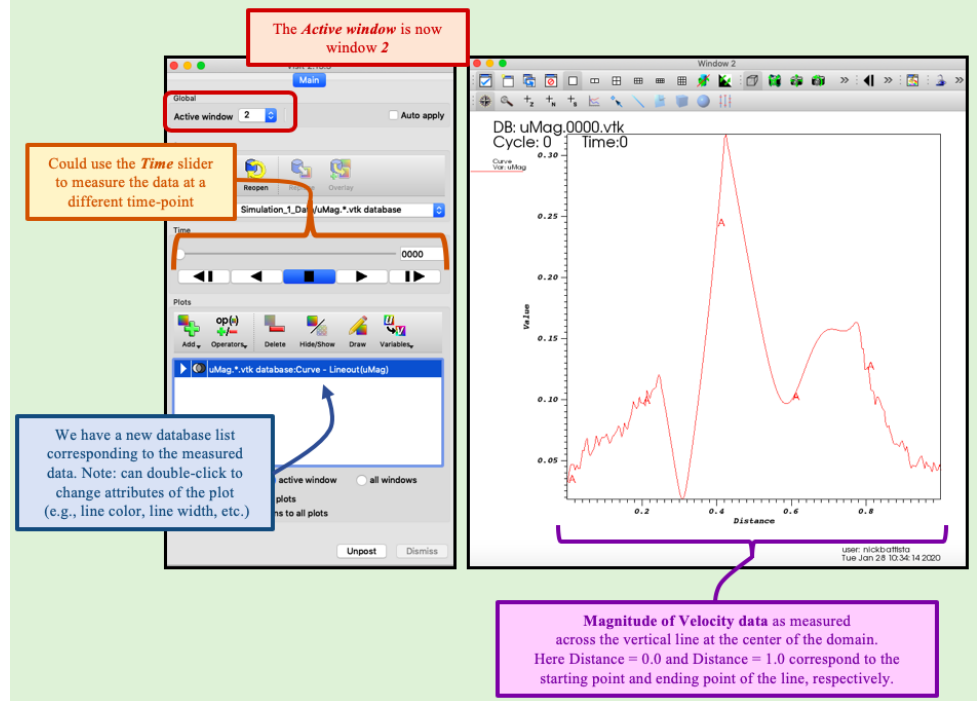
Figure 18. Illustrating the Active window change to window 2 as well as a plot of the magnitude of velocity (selected data) as measured across a vertical line at the center of the domain.